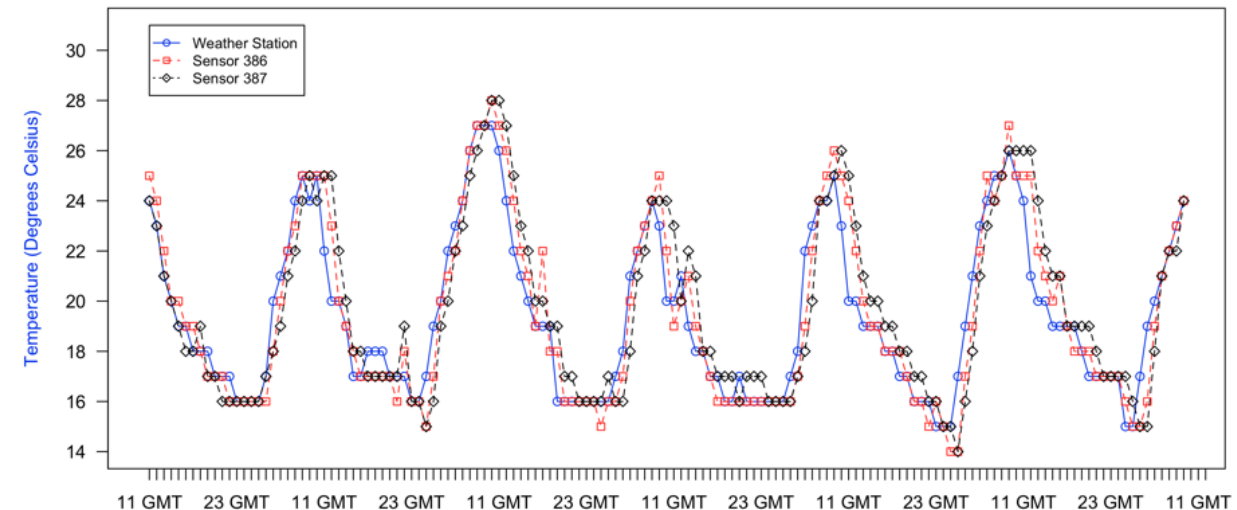
Figure 8. Comparison between the humidity sensor (in enclosures) and the